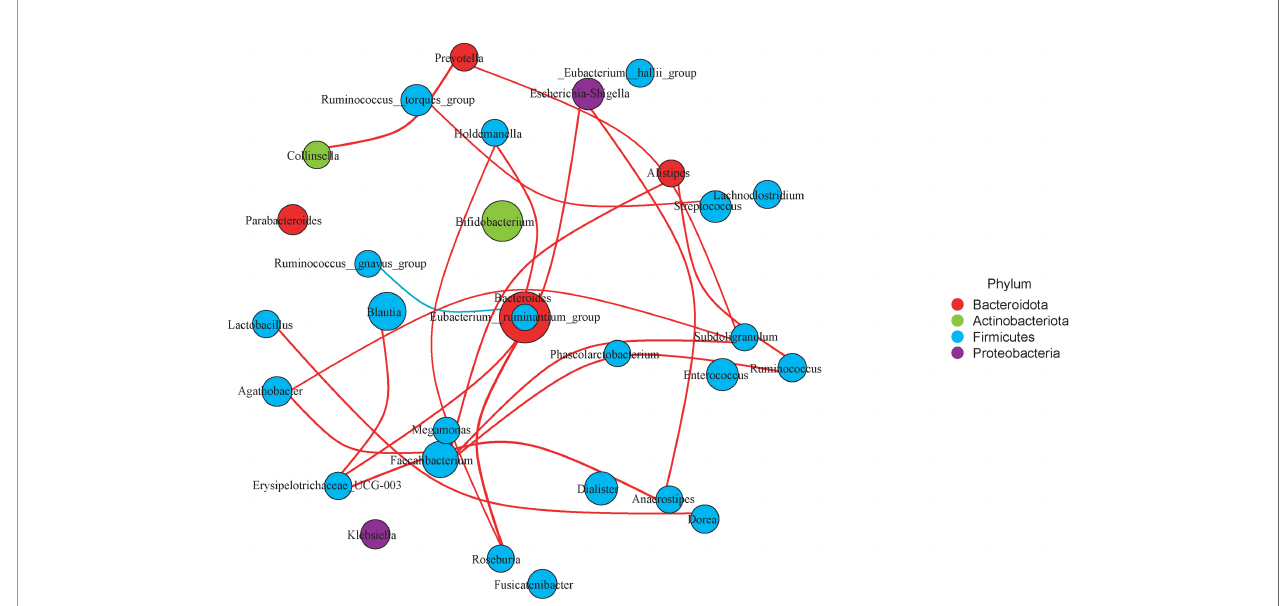
FIGURE 7 | Microbiota network of LT group. Choose the top 30 microbiota taxon of LT group and detect correlations of them (Spearman ’ s rank correlation coef fi cient>0.6, adjusted P<0.05). The red lines represent a positive correlation, and the blue lines represent negative